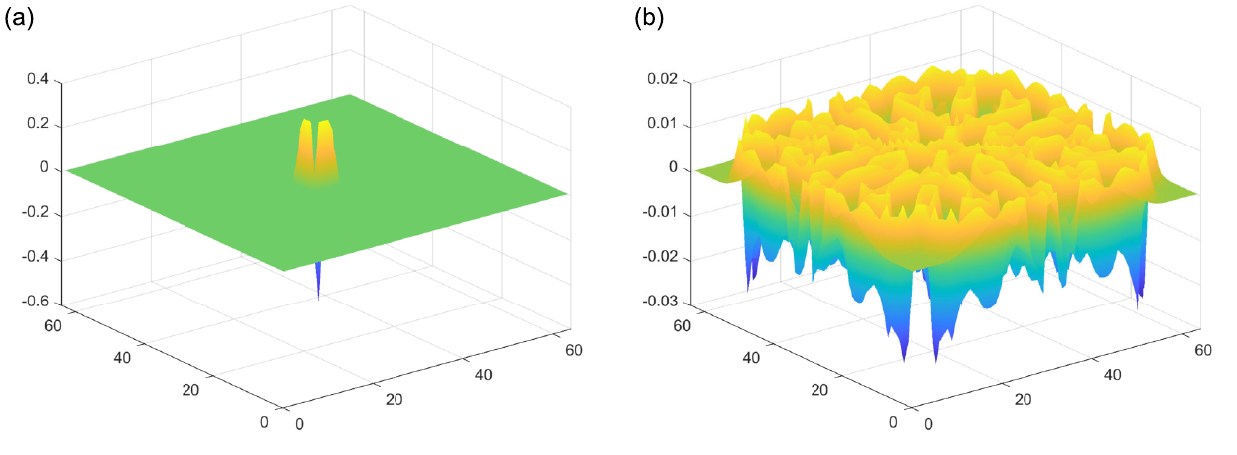
Figure 4. ( a ) Laplacian function for the initial condition of the activator, showing the direction and rate of the diffu- sion gradients. ( b ) Laplacian function for the activator at the end time point, showing the direction and rate of the diffusion gradients.